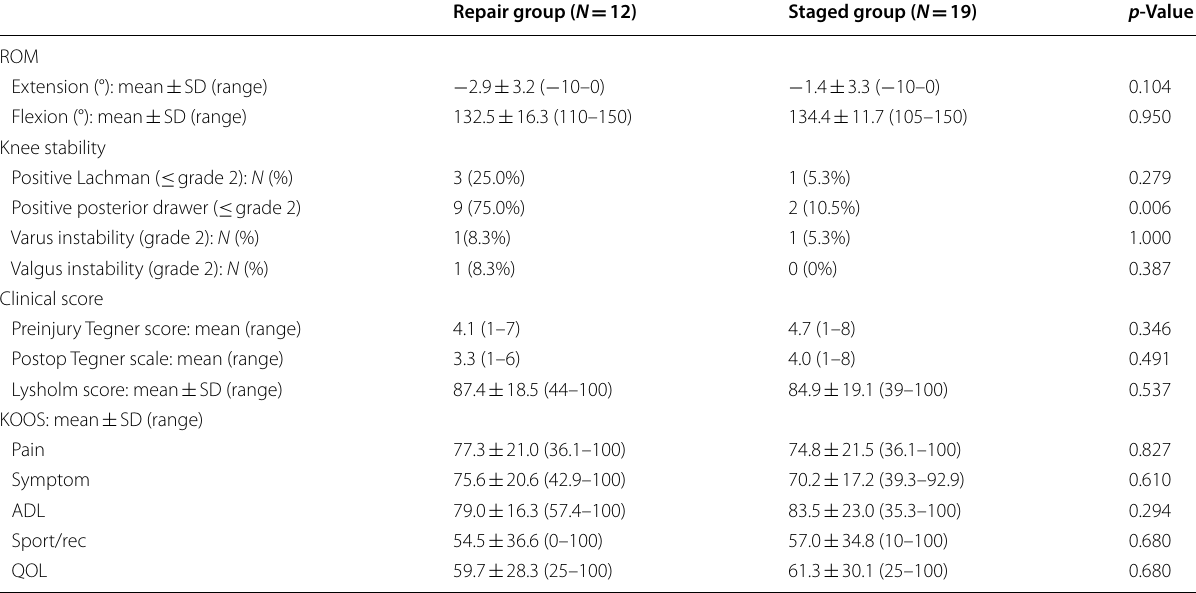
SD standard deviation, N number, KOOS Knee Injury and Osteoarthritis and Outcome Score, ROM range of motion, ADL activities of daily living, QOL quality of